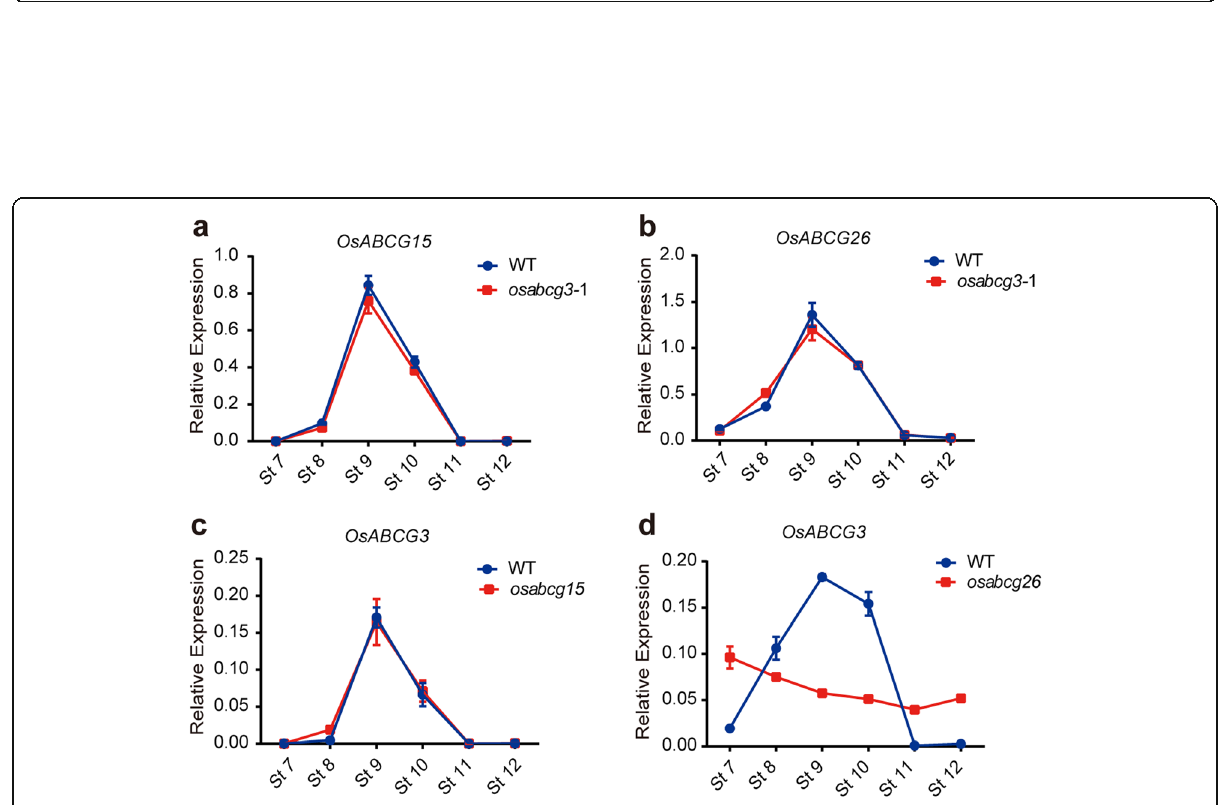
Fig. 7 Expression of OsABCGs in WT and mutant anthers. Expression of OsABCG15 in the WT and osabcg3 – 1 (a) , OsABCG26 in the WT and osabcg3 – 1 (b) , OsABCG3 in the WT and osabcg15 (c) , and OsABCG3 in the WT and osabcg26 (d) were analyzed using qRT-PCR. OsACTIN1 served as an internal control. Data are shown as means ± SD ( n